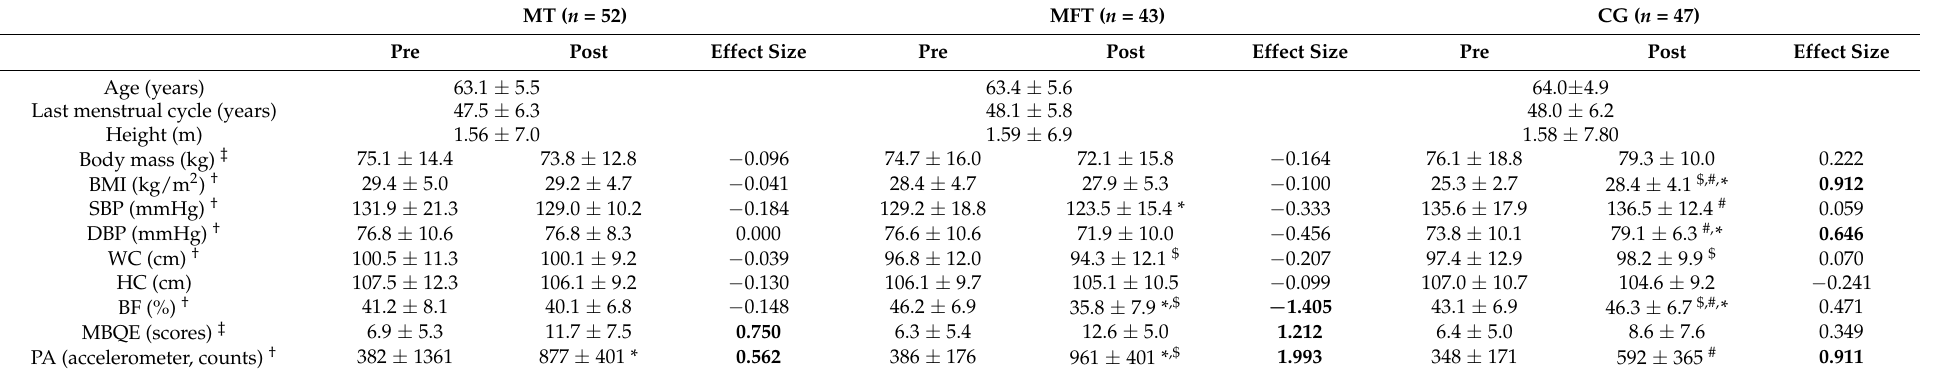
Table 2. Characterization of the participants at the pre and post experimental period moments.